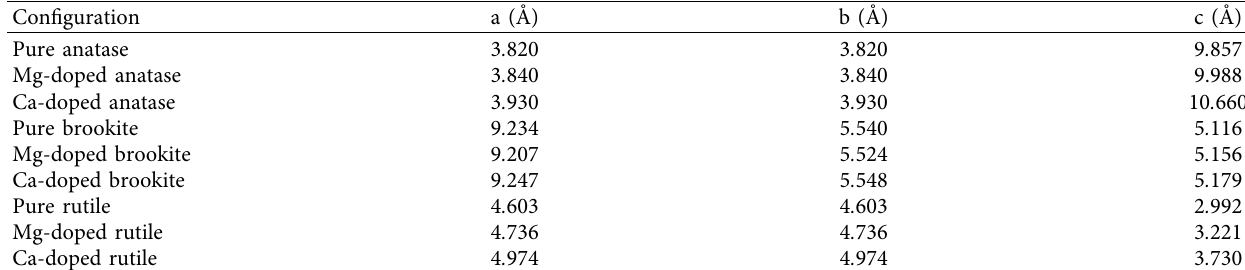
Table 1: The optimized structural parameters of pure and doped polymorphs.